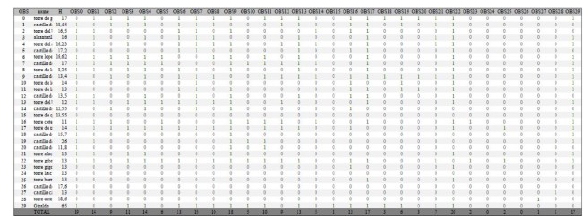
Figure 8. Table showing the visual lines between towers without considering visual acuity. The values “0” and “1” mean without and with visual connection, respectively.